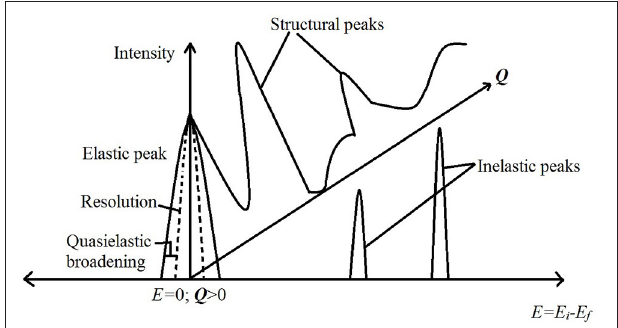
FIGURE 3 | A cartoon schematic depicting the information obtained from a neutron scattering experiment. The horizontal axis is the energy transfer while the vertical direction depicts intensity of scattered neutrons. The third dimension going into the page is the Q axis. Peaks on the Q axis are obtained by not discriminating the scattered neutrons in energy (i.e., integrating all energies) and are structural peaks revealing information about the structure in the sample. The peak at E = 0 is the elastic peak. A broadening of this elastic peak contains information on the stochastic motion of molecules and is measured in quasielastic neutron scattering (QENS). The peaks at non-zero energies are due to periodic motion of molecules in the sample and are measured in an inelastic neutron scattering (INS)